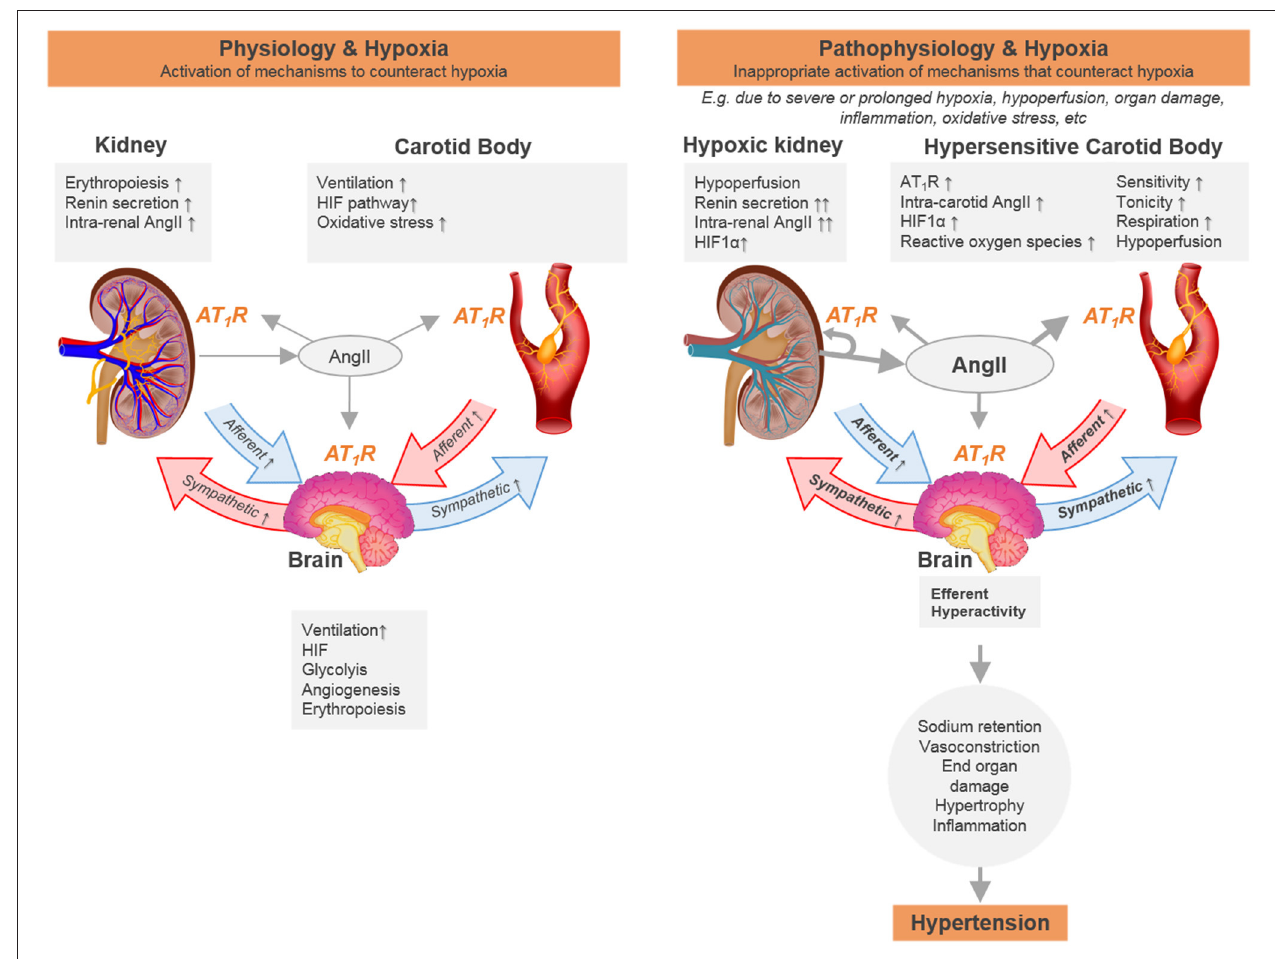
FIGURE 1 | Schematic representation of the hypothesis that chronic hypoxia sensed by carotid body and kidney is essential for physiological adaptation and when over-activated can contribute to cardiovascular disease due to positive cross-organ interactive feedback mechanisms. We propose a temporal sequence to the reflex responses elicited between the two organs. One potential way of how the transition from one state to the other would occur includes the inability of the kidney to overcome tissue hypoxia during pathological conditions related to hypoperfusion and/or increased metabolic rate (e.g., vasoconstriction, mitochondrial dysfunction, hyperfiltration). Signals cascading from the hypoxic kidney activate the carotid body that acts cooperatively to ensure sustained (and in the end aberrant) long term sympathoexcitation. Furthermore, the renin angiotensin system is activated in both organs in response to low blood flow/hypoxia. This chronic low blood flow/hypoxia together with the activation of the renin angiotensin system forms a non-functional positive feedback loop that leads to tissue damage. Increasing the renin angiotensin system will lead to activation of different pathways to ensure proper oxygen delivery, including hypoxia inducible factor and erythropoiesis, that may also contribute to the dysfunctional sympathetic activation in